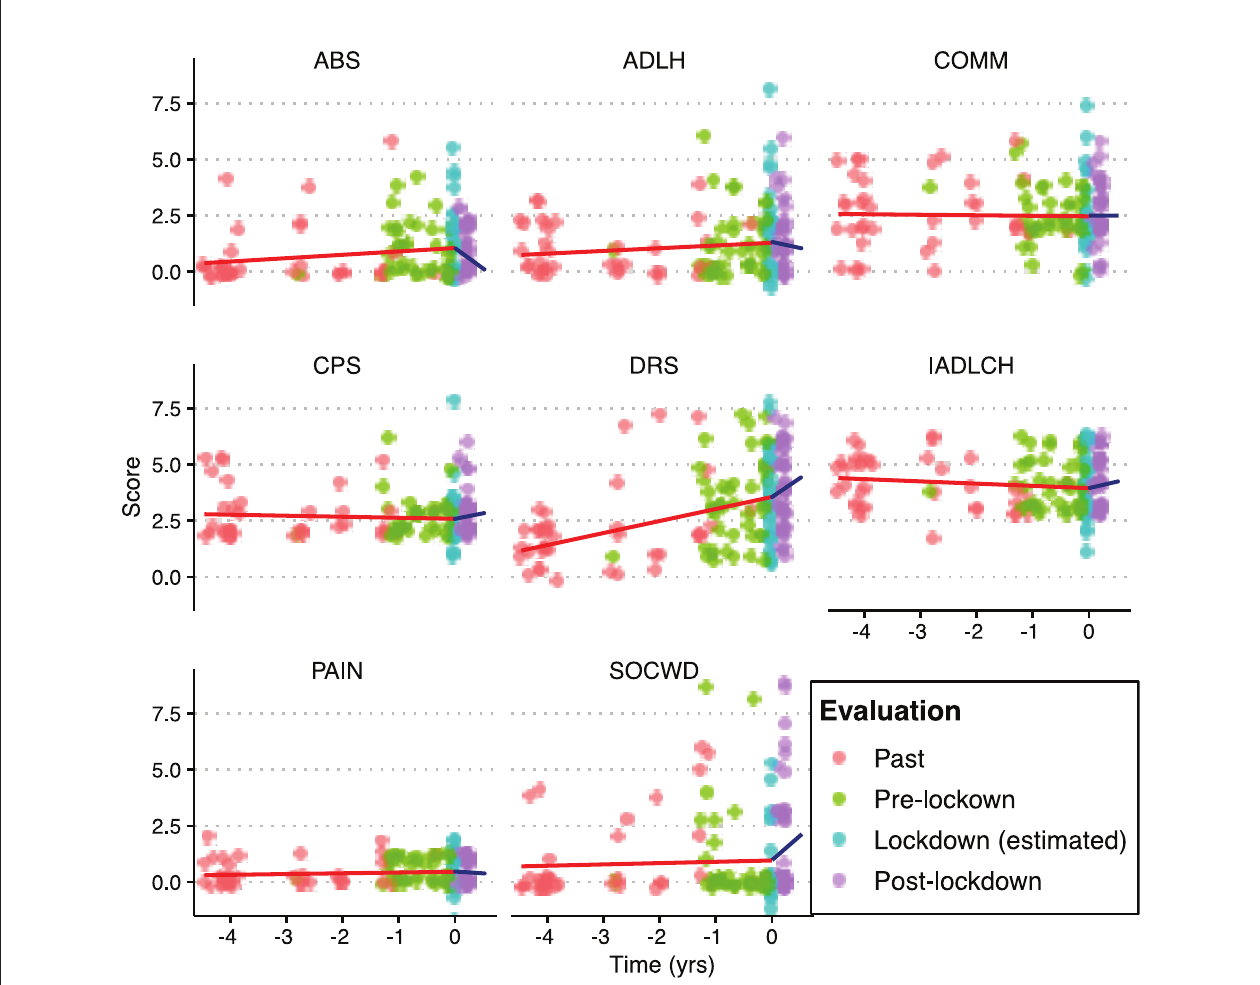
FIGURE 1 | Rate of change over time of physical and mental health scales before and after the lockdown. Points represent the scores obtained by each individual in the different evaluation events. Fit line in the pre-lockdown phase in red color; fit line in the post-lockdown phase in blue color. The fit parameters are specified